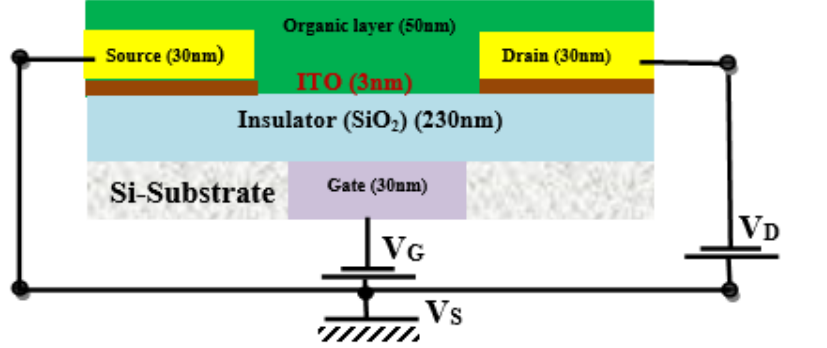
Figure 1. A schematic view of the bottom-gate bottom-contact organic thin-film transistors used in this experiment with its polarization condition. Table 1. Organic semiconductors that were applied as an active layer and the device abbreviation names.